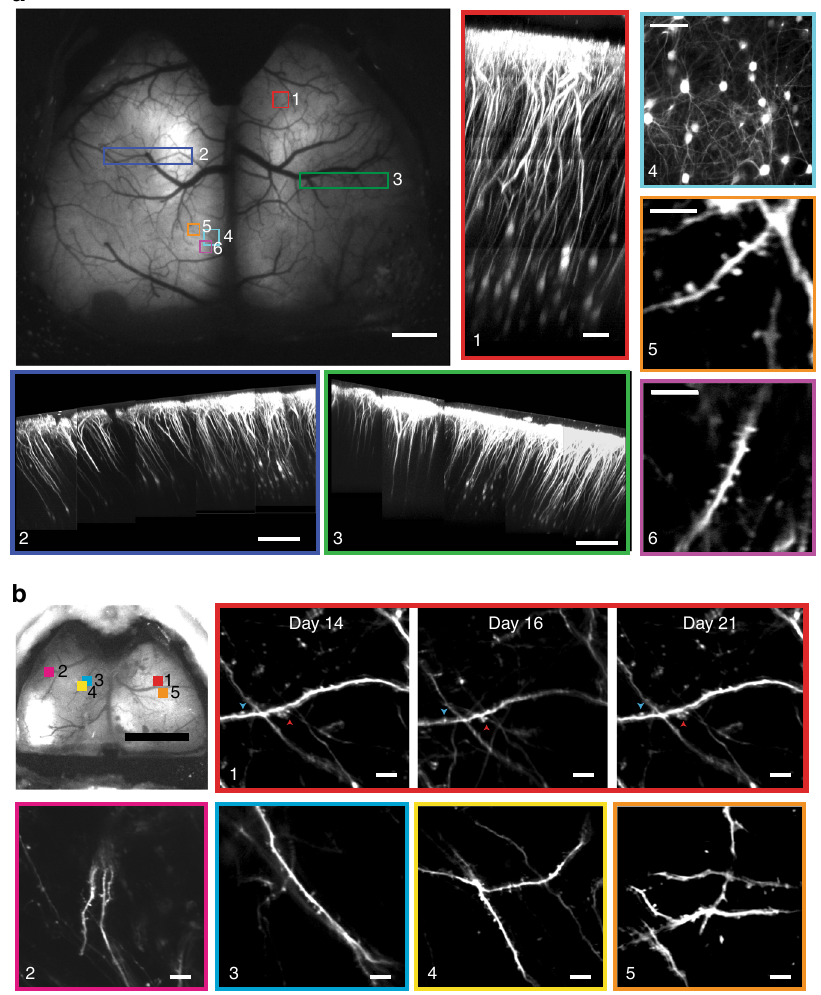
Fig. 3 See-Shells allow structural imaging from mesoscale to microscale. a Wide- fi eld image of a Thy1-YFP mouse implanted with a See-Shell taken 2 weeks after implantation. Locations marked with colored blocks were targeted for two-photon (2P) imaging. Scale bar indicates 1 mm. Inset #1: Imaging of a whole cortical column at the location marked by red block in the wide- fi eld image. Scale bar indicates 80 µ m. Inset #2 and #3: Composite images of cortical columns imaged from large contiguous areas denoted by the blue and green blocks in the wide- fi eld image. Scale bar indicates 200 µ m. Inset #4: High-resolution image of layer 2/3 pyramidal neurons imaged from the cyan block denoted in the wide- fi eld image. Scale bar indicates 80 µ m. Inset #5 and #6: Dendrites with dendritic spines of layer 2/3 neurons imaged at ~245 µ m depth from the orange and magenta blocks shown in the wide- fi eld image. Scale bars indicate 10 µ m. b Wide- fi eld image of a Thy1-GFPm mouse implanted with a See-Shell obtained 2 weeks after implantation. Locations marked with colored blocks were targeted for 2P imaging. Scale bar indicates 2 mm. Inset #1: Longitudinal 2P structural imaging of dendritic structures within the red block outlined on the wide- fi eld image on the left taken in multiple experiments over 1 week. Scale bar indicates 10 µ m. Insets #2 – #5: Multi-site 2P imaging of dendritic structures at locations indicated by blocks 2 – 5 in the wide- fi eld image. Scale bar indicates 10 µ m NATURE COMMUNICATIONS| (2019) 10:1500